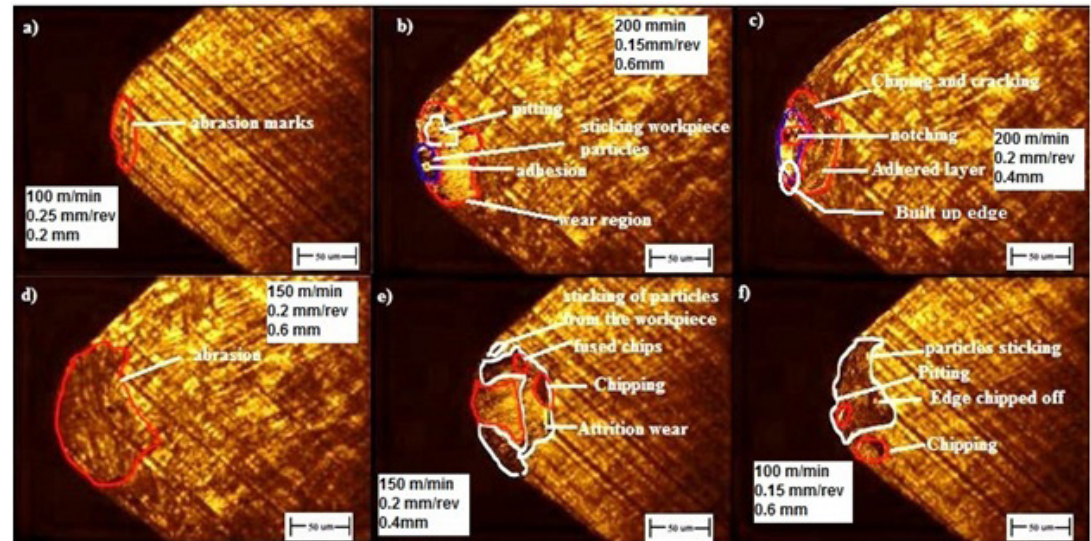
Figure 9. wear formation on cutting tool under different cutting speed, feed and depth of